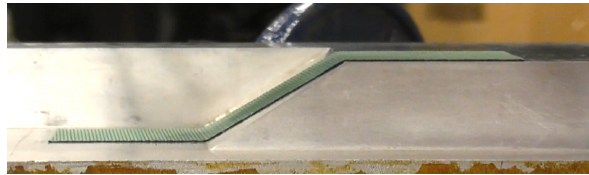
Figure 6: Image of a ply successfully laid onto a curved mould shape by the